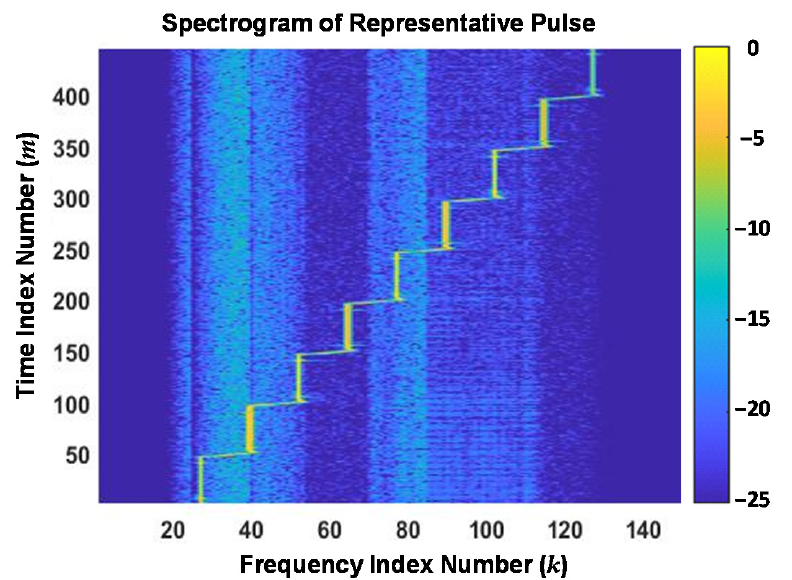
Figure 4. Normalized time-frequency spectrogram of the same representative DUT stimulated output used to generate the Figure 3 time domain magnitude response.